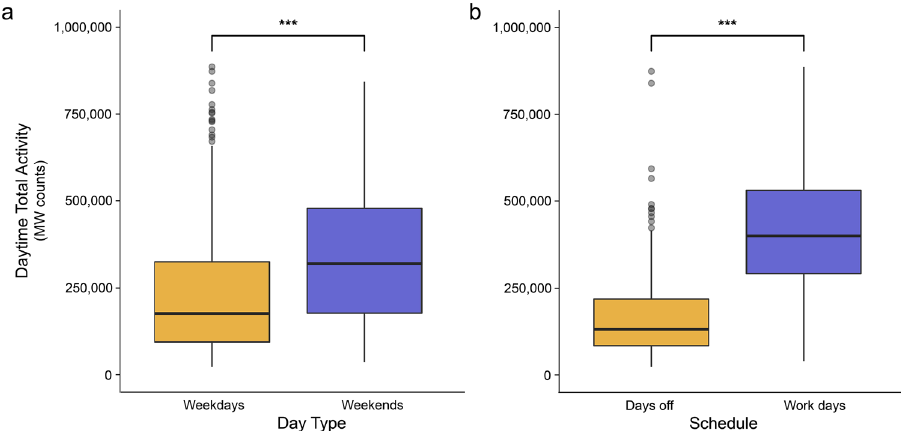
Figure 1. Box plot comparing the daytime activity of Canmore dogs on ( a ) weekdays and weekends, and ( b ) workdays and days off. Asterisks (***) indicate significant (P < 0.05) difference between groups.